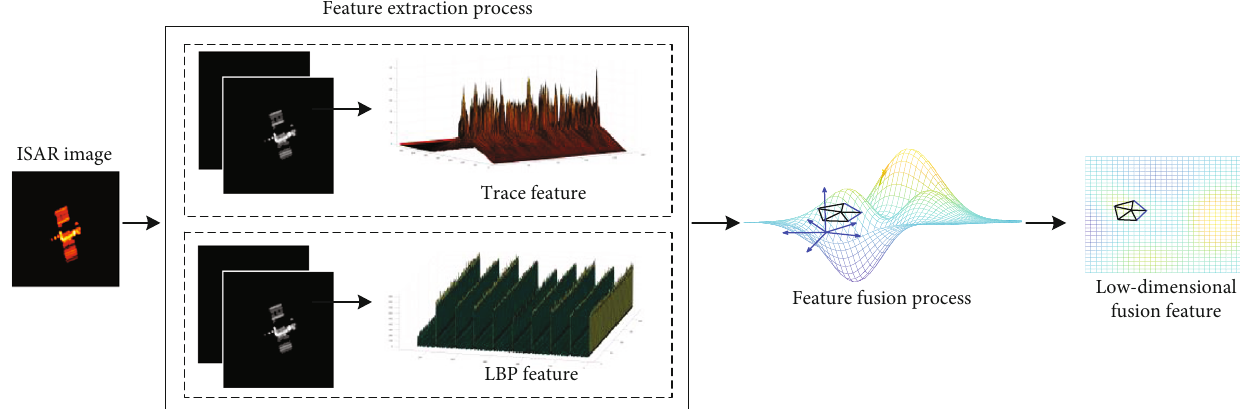
Figure 12: Schematic diagram of using the manifold learning method to fuse